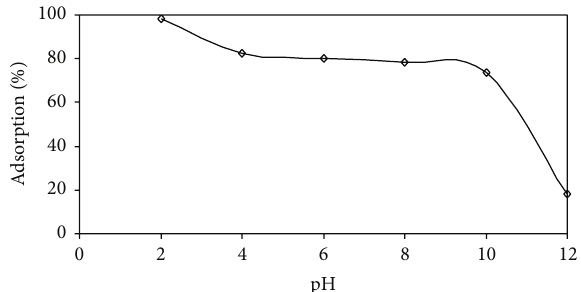
Figure 6: Effect of pH on equilibrium uptake of AB25. Conditions: agitation time = 3 h; 𝐶 0 = 50 mg L −1 ; 𝑉 = 0.025 L; Temp. = 35 ± 1 ∘ C; speed of agitation = 180rpm; size of IJSP = < 53 𝜇 m; and dose = 100 mg.